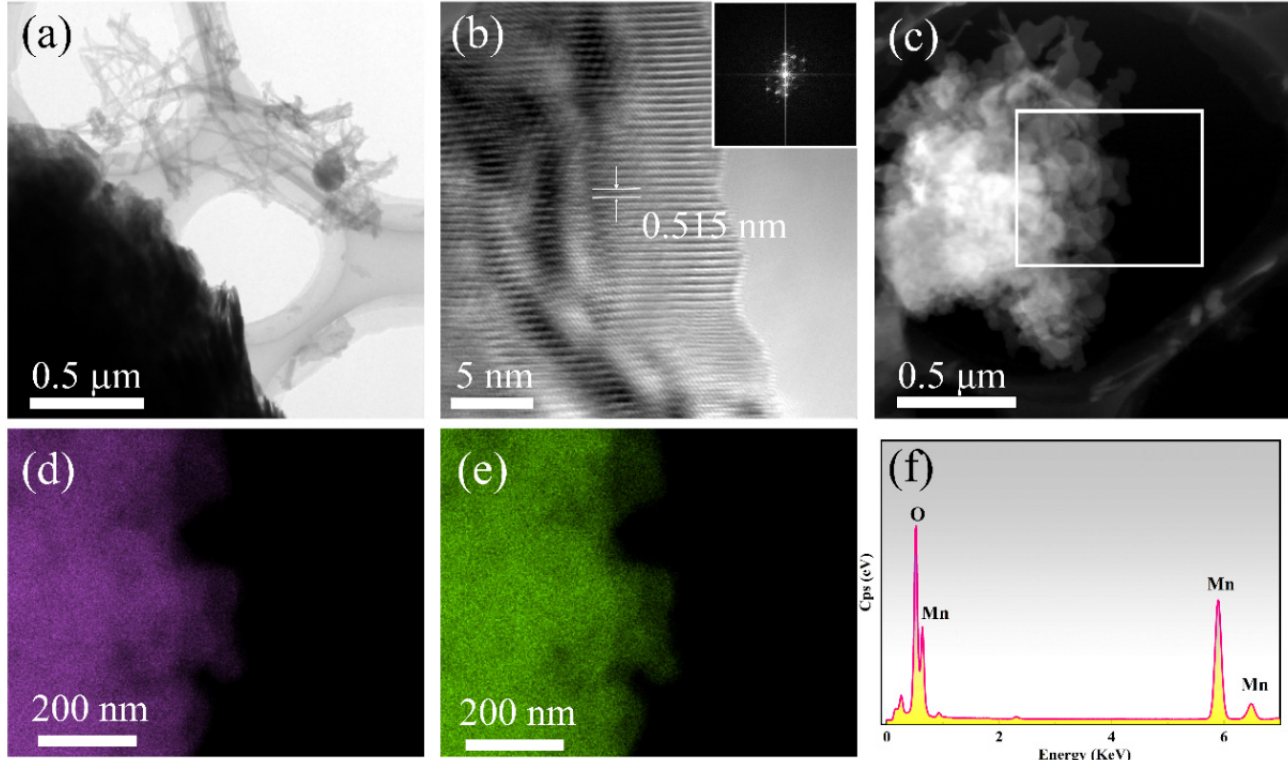
Figure 2. ( a ) TEM image, ( b ) HRTEM image and SAED pattern, ( c ) HAADF image of Mn(OH) 2 nanowires. ( d – f ) Elemental mappings of Mn and O and EDS spectrum of the products.